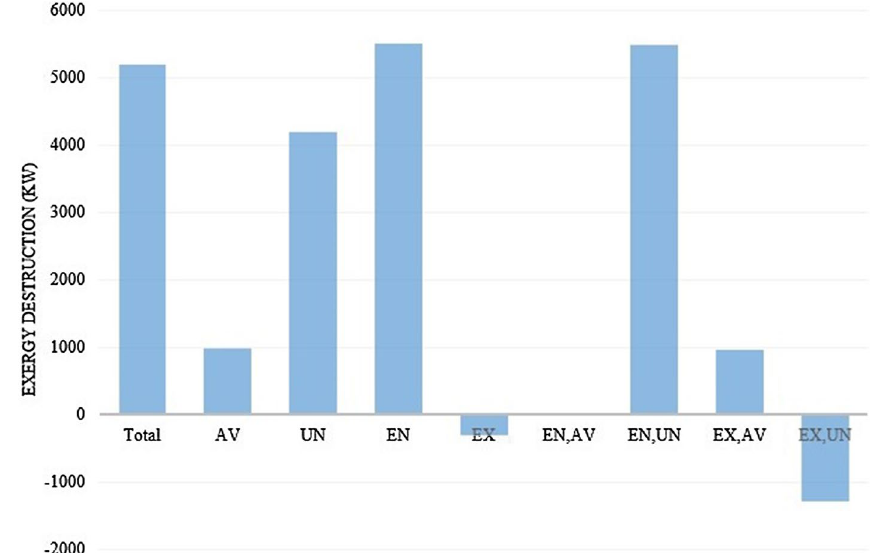
Fig. 5 Bar chart of different parts of exergy destruction for all the system